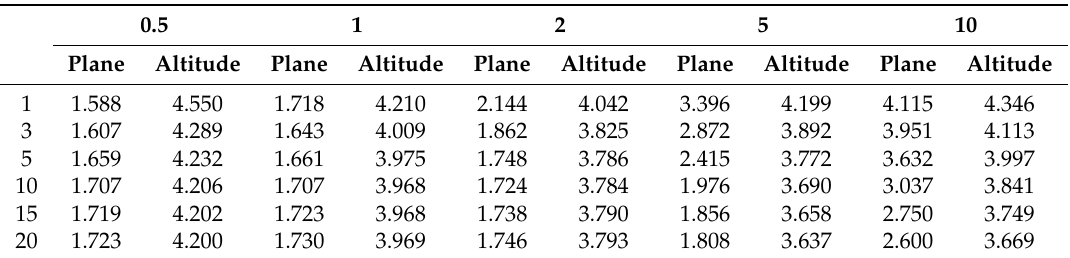
Table 8. Geometric accuracy with different scale and rotation parameters for GF2 and GF3 combined